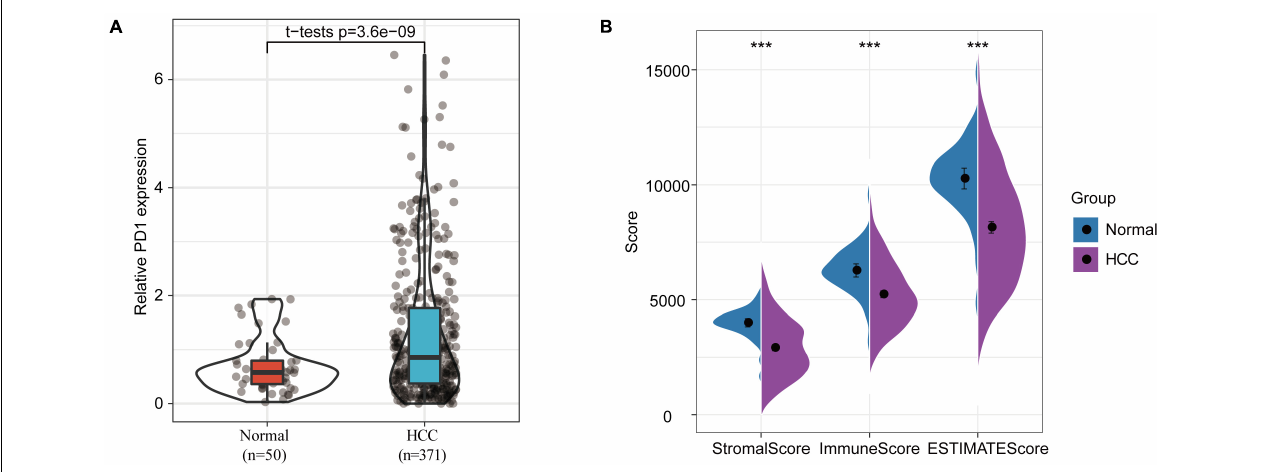
FIGURE 1 | Differences in immune infiltration between normal and HCC samples. (A) PD-1 expression differences between normal and HCC samples. (B) Differences in stromal scores, immune scores, and ESTIMATE scores between normal and HCC samples, ∗∗∗ p <